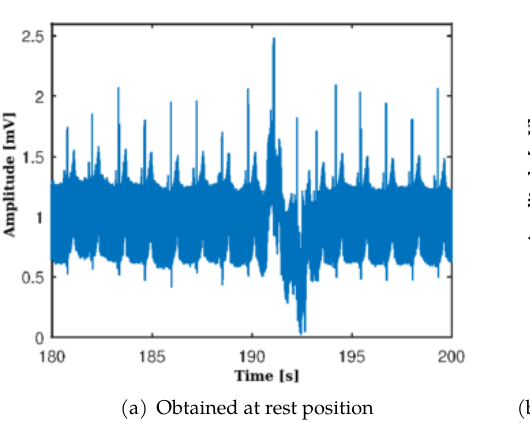
Figure 6: ECG signal of one subject. ParadigmPlus (2021)